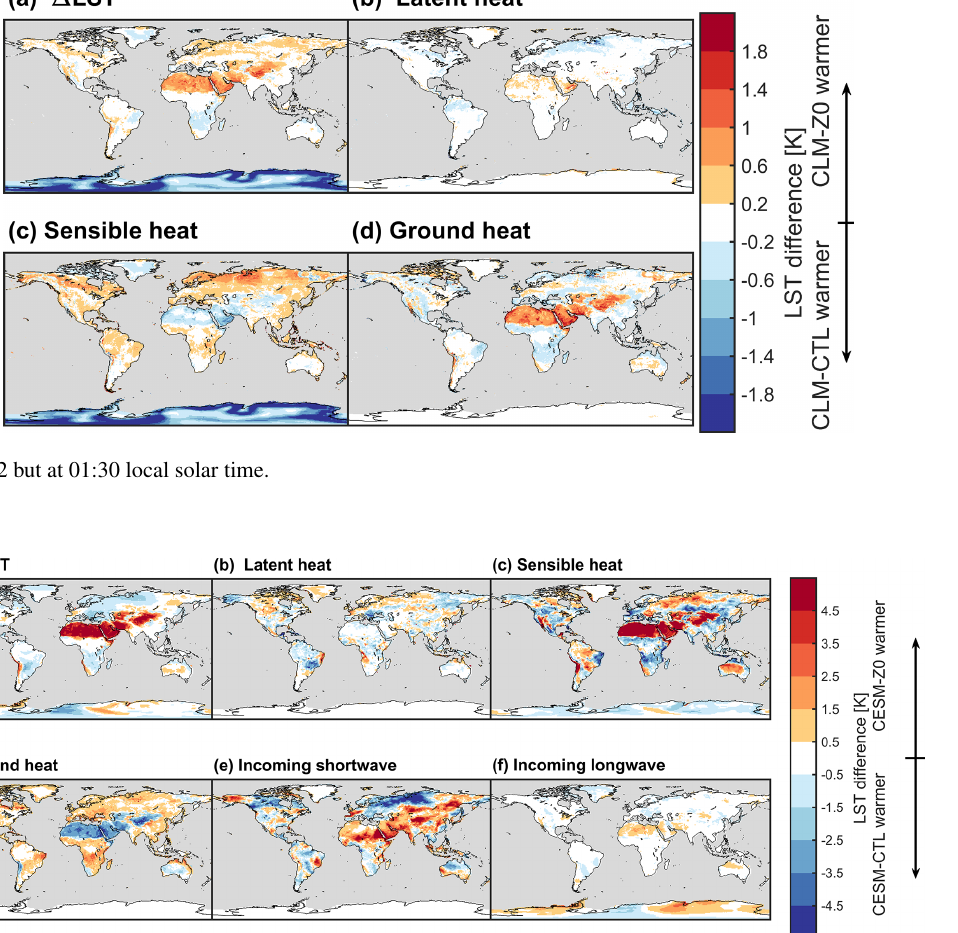
Figure A4. Energy balance decomposition for change in LST at 13:30 local solar time in boreal summer of CESM-Z0 minus CESM-CTL. (a) Change in LST, (b) contribution from change in latent heat, (c) contribution from change in sensible heat, (d) contribution from change in ground heat flux, (e) contribution from change in incoming shortwave radiation, and (f) contribution from change in incoming longwave radiation. Note that the albedo and the imbalance term are not shown because they are small.